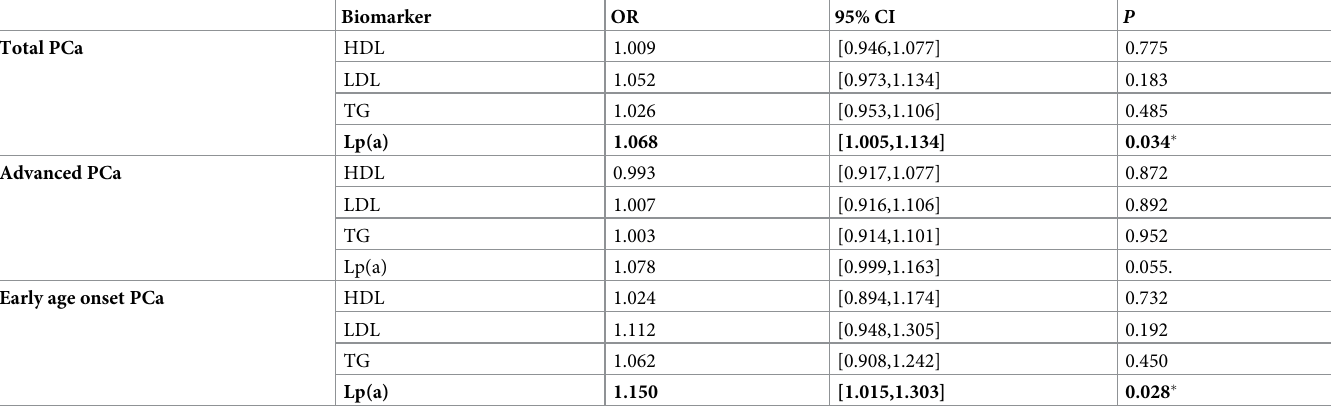
Table 2. MVMR results for each PCa